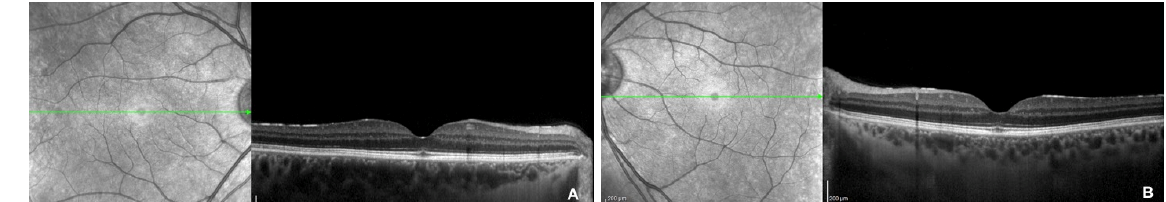
Figure 4: Almost complete resolution of the foveal changes was observed on SD OCT 1 month later; A) OD, B) OS